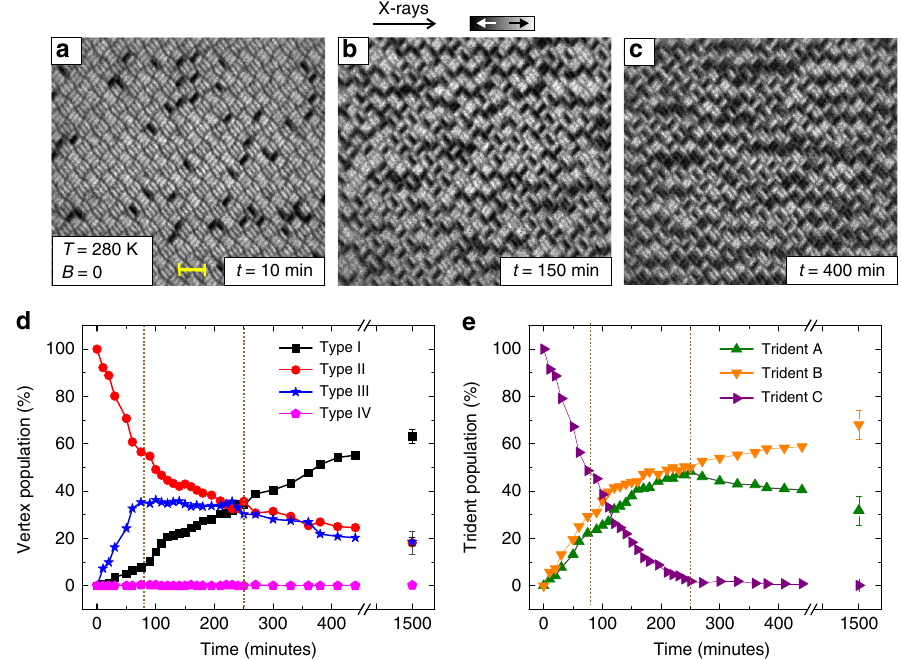
Fig. 2 Thermal relaxation of the dipolar trident lattice. a – c XMCD images of the dipolar trident lattice undergoing thermally induced magnetic relaxation from a magnetically saturated state to a low-energy equilibrium con fi guration. The yellow scale bar indicates a length of 1 µ m. d Experimentally obtained temporal evolution of vertex-type population extracted from XMCD images recorded at a constant temperature ( T = 280 K). e Trident population plotted for the same relaxation